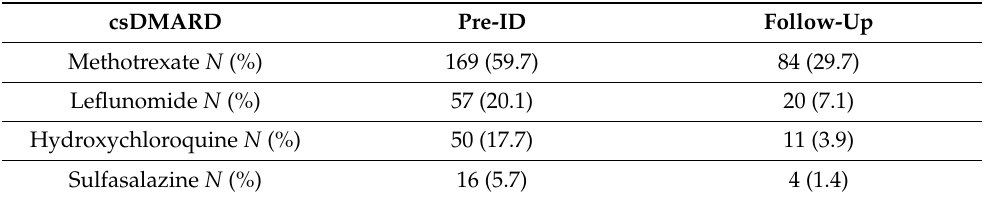
Figure 4. Treatment patterns in the bDMARD-naïve baricitinib users ( N = 283) ( a ) in the 12 months before ID (pre-ID); ( b ) during follow-up. Abbreviations: csDMARDs, conventional synthetic disease-modifying antirheumatic drugs; CS, corticosteroids. Table 2. Most frequently prescribed csDMARDs to bDMARD-naïve patients ( N = 283) during the pre-ID and follow-up period in the baricitinib cohort.